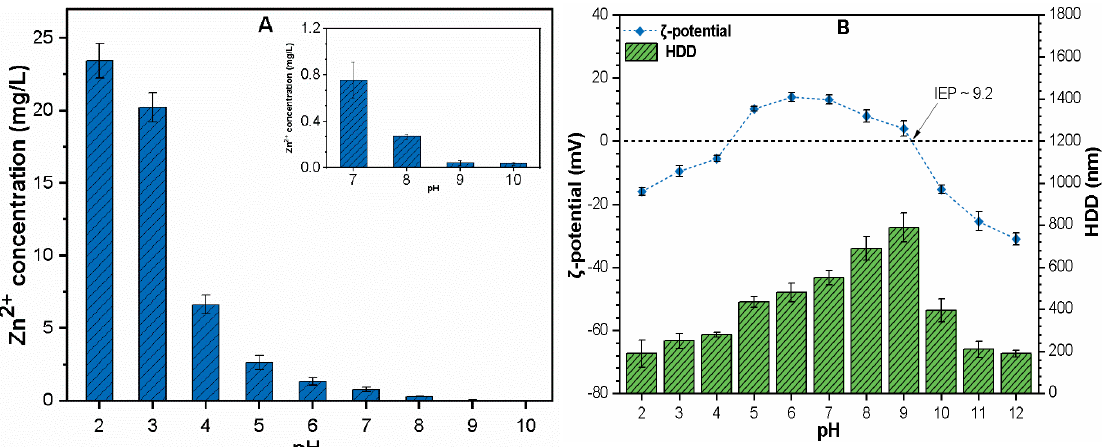
Figure 1. ( A ) Zn 2+ released (mg/L); ( B ) ζ -potential and HDD profile of ZnO NPs (30 mg/L) suspension (mean ± SD, n = 3) as a function of varying pH. The inset in (Figure 1A) was the same enlarged figure from pH 7 to 10.